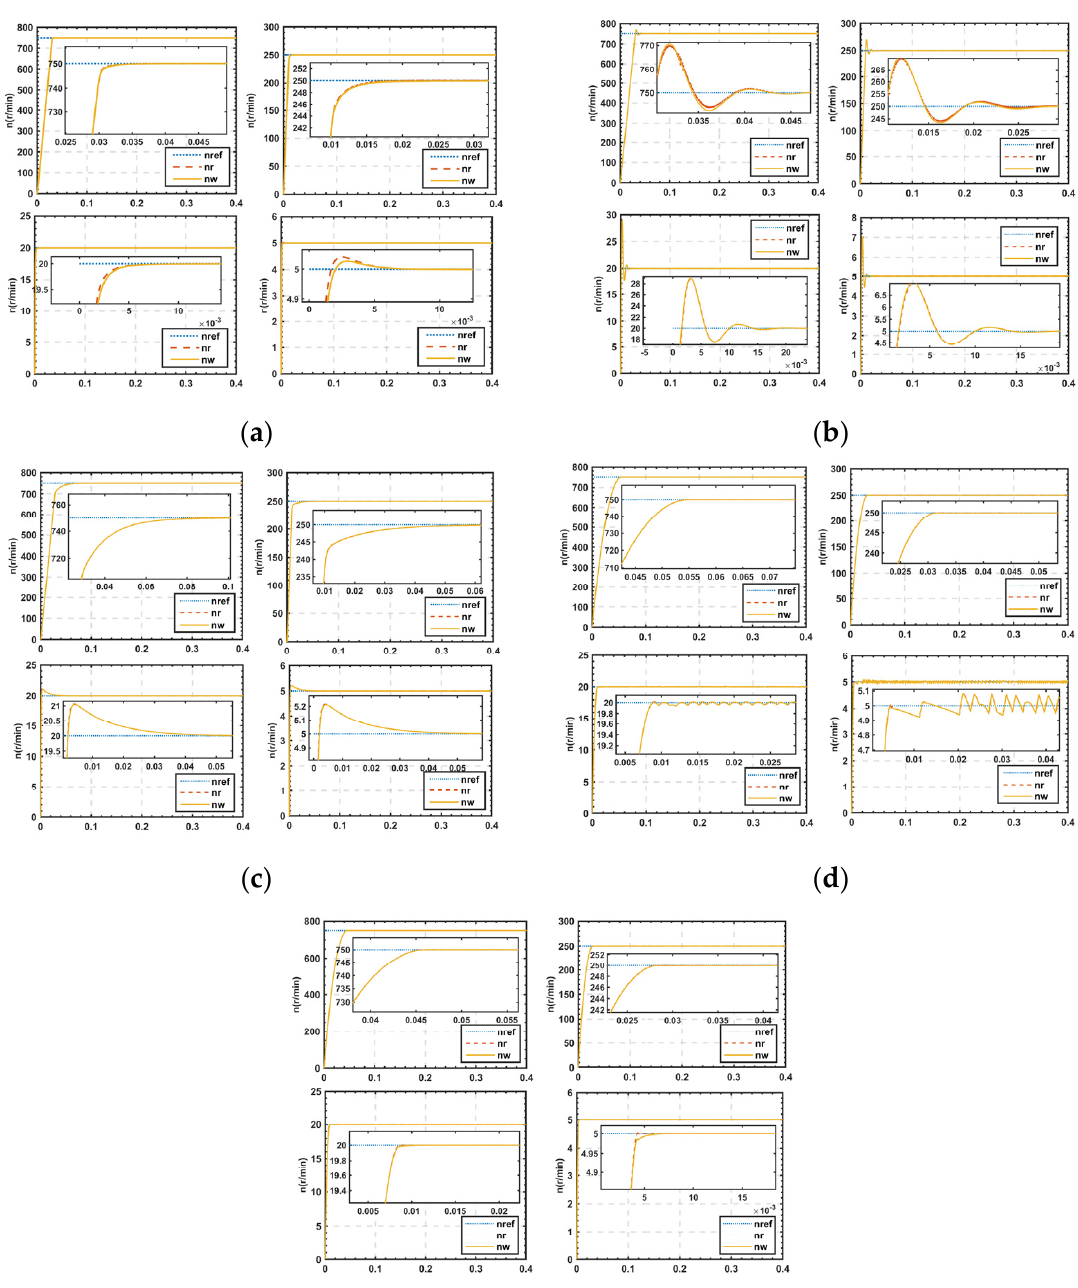
Figure 10. ( a ) Estimated speed versus response speed for different speeds of the CVSPI. ( b ) Estimated speed versus response speed for different speeds of the PI. ( c ) Estimated speed versus response speed at different speeds of AWPI. ( d ) Estimated speed versus response speed at different speeds of the ADRC. ( e ) Estimated speed versus response speed for different speeds of the STA. Table 7. Comparison of step and ramp signal